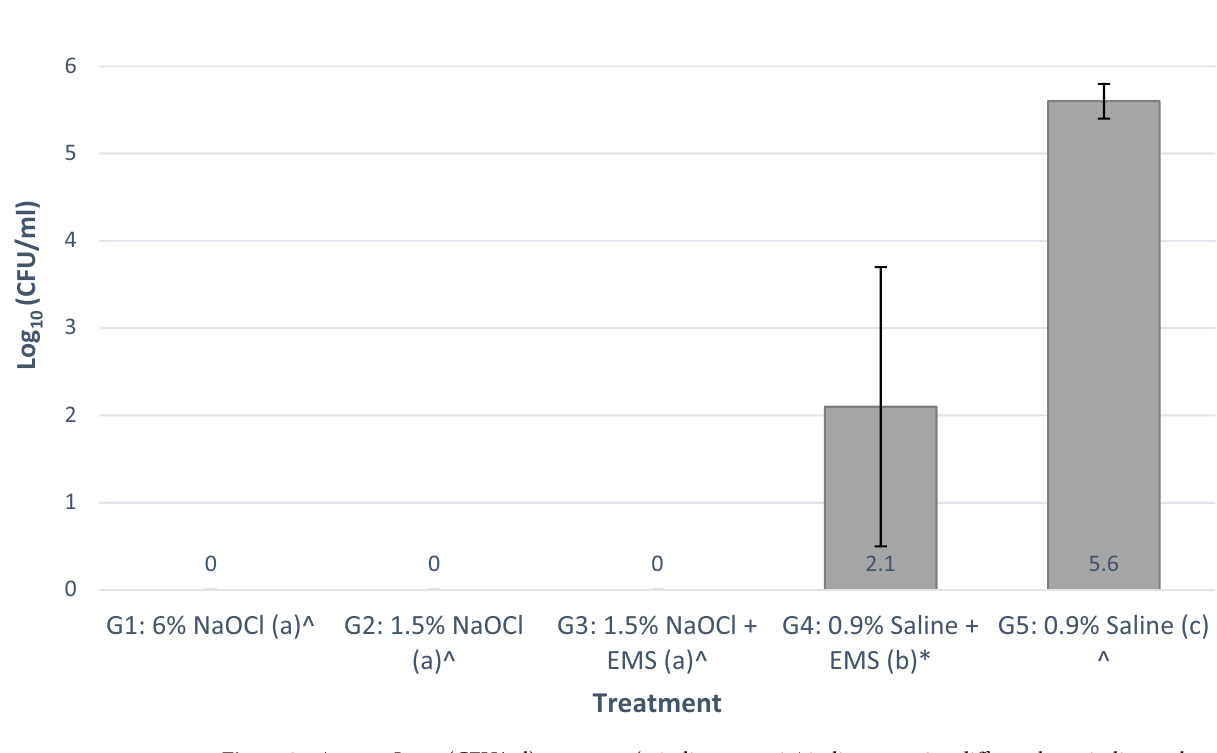
Figure 3. Average Log 10 (CFU/ml) per group (^ indicates n = 6; * indicates n = 8; a different letter indicates that group was statistically significant from the other